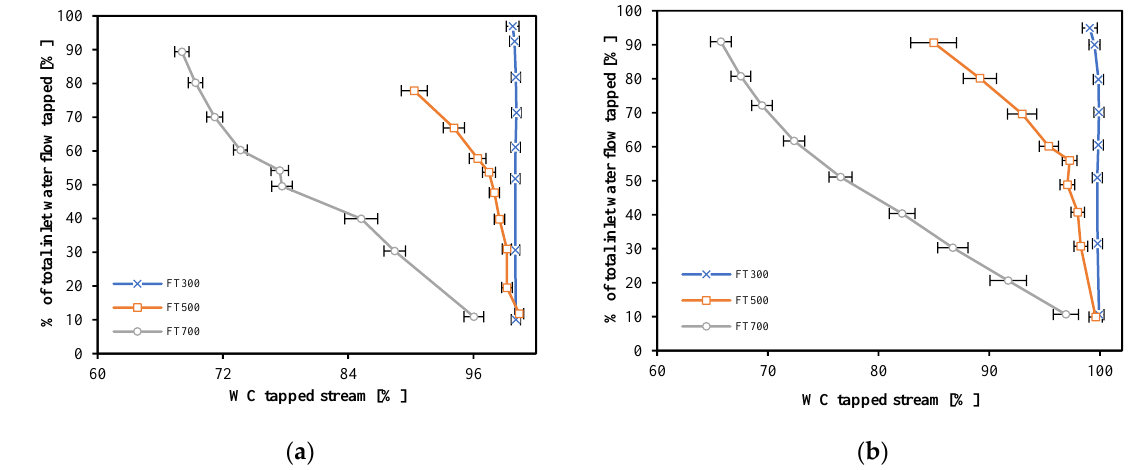
Figure 13. Drainage potential for ( a ) unspiked, ( b ) spiked oil and water at WC inlet 50%, total flow rate of 300, 500, and 700 L/min.